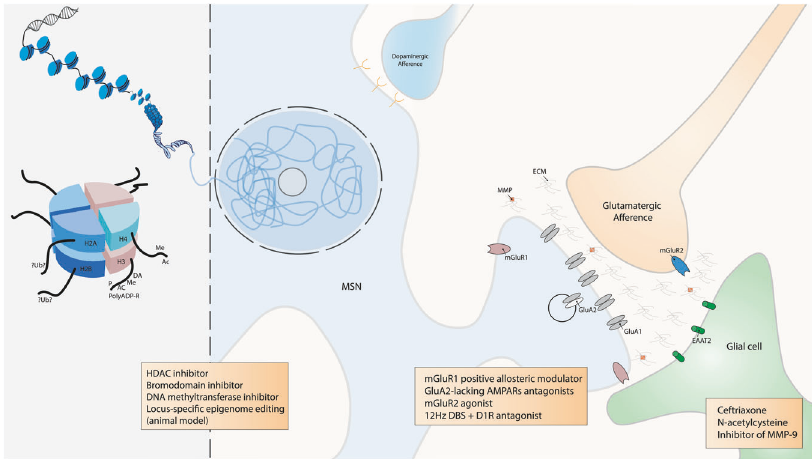
Fig. 3 Scheme of epigenetic and tetrapartite synaptic drug-induced modi fi cations seen as potential target of promising therapeutics. DNA is packaged inside nuclei with the help of histones. These are positively charged proteins that strongly adhere to negatively charged DNA and form complexes called nucleosomes. Each nucleosome is composed of DNA wound around histone octomers (H2A, H2B, H3 and H4). Nucleosomes fold up to form chromatin fi bre, which forms loops compressed and folded to produce fi bres, which are coiled into the chromatid of a chromosome. Only by loosening compacted chromatin, the DNA of a speci fi c gene can be made accessible to transcription. Some of these drug-induced modi fi cations at the chromatin level are extremely stable and sustain the drug of abuse-induced long-term behaviours. Among them, histone post-translational modi fi cations (PTMs) are known to be causally involved in drug-induced behaviours [194]. PTMs include acetylation (Ac), methylation (Me), phosphorylation (P), ADP ribosylation (PolyADP-R) and dopaminylation (DA), among a growing list of newly discovered modi fi cations [162, 172]. For example, while ubiquitylation (Ub) of H2A is known to be a key interactor of H3 methylation [253], its supposed role in drug addiction is still unknown. At this epigenetic level, some drugs were demonstrated to have an drug of abuse targets. Overview of the tetrapartite glutamatergic synapse composed of a medium spiny neuron (MSN), a glutamatergic projection, a glial cell and the extracellular matrix (ECM). Here, we focused on synaptic potentiation after drug of abuse administration